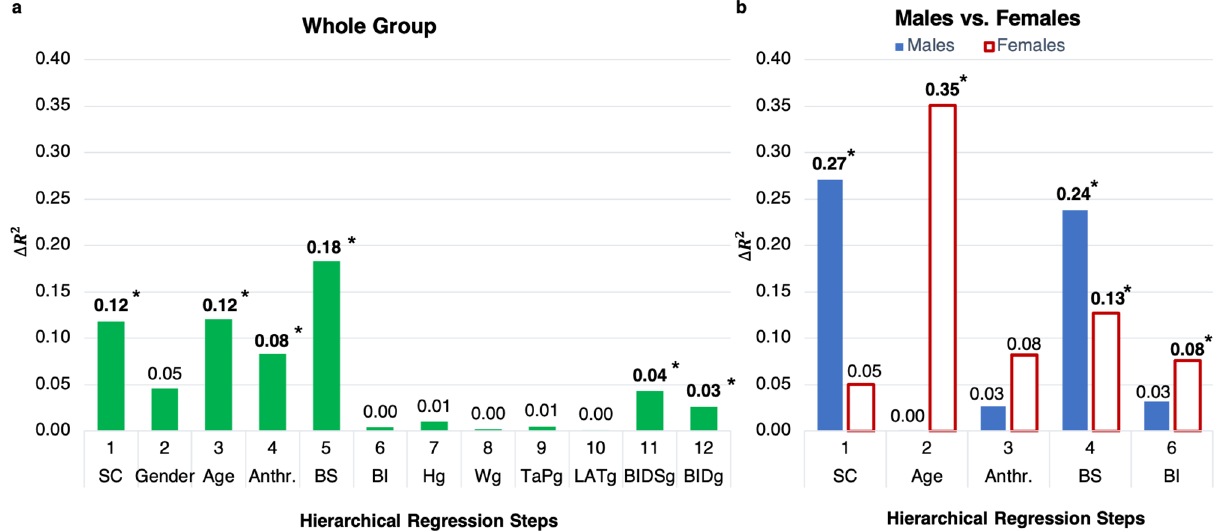
Figure 1. Regression results (entry method) for whole group ( a ) and for gender groups ( b ). (cid:31) R 2 for each hierarchical regression step. SC = sensory condition (eyes closed (EC); neck extended, eyes closed (NE-EC)); Gender (male; female); Anthr. = anthropometry (height (H); weight (W)); BS = body schema ( TaP v ; LAT a ); BI = body image ( BIDS abs ; BID abs ); gender-interactions: Hg, Wg, TaPg, LATg, BIDSg, BIDg. Bold with star indicates significance ( P ≤ 0.05